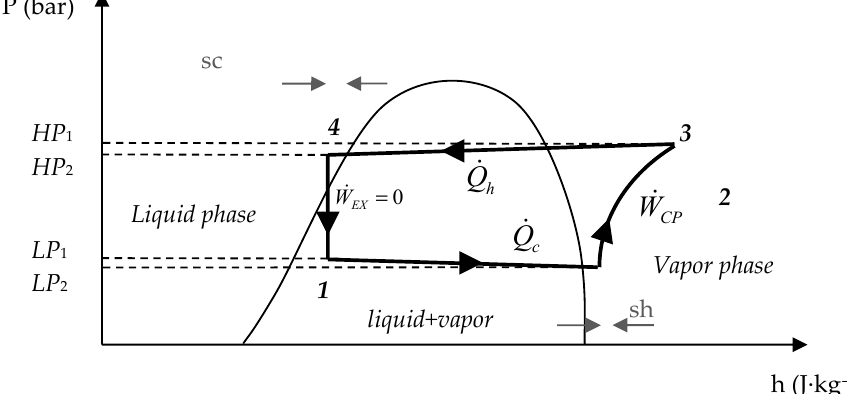
Figure 1. “Real” heat pump cycle in the P-h diagram.